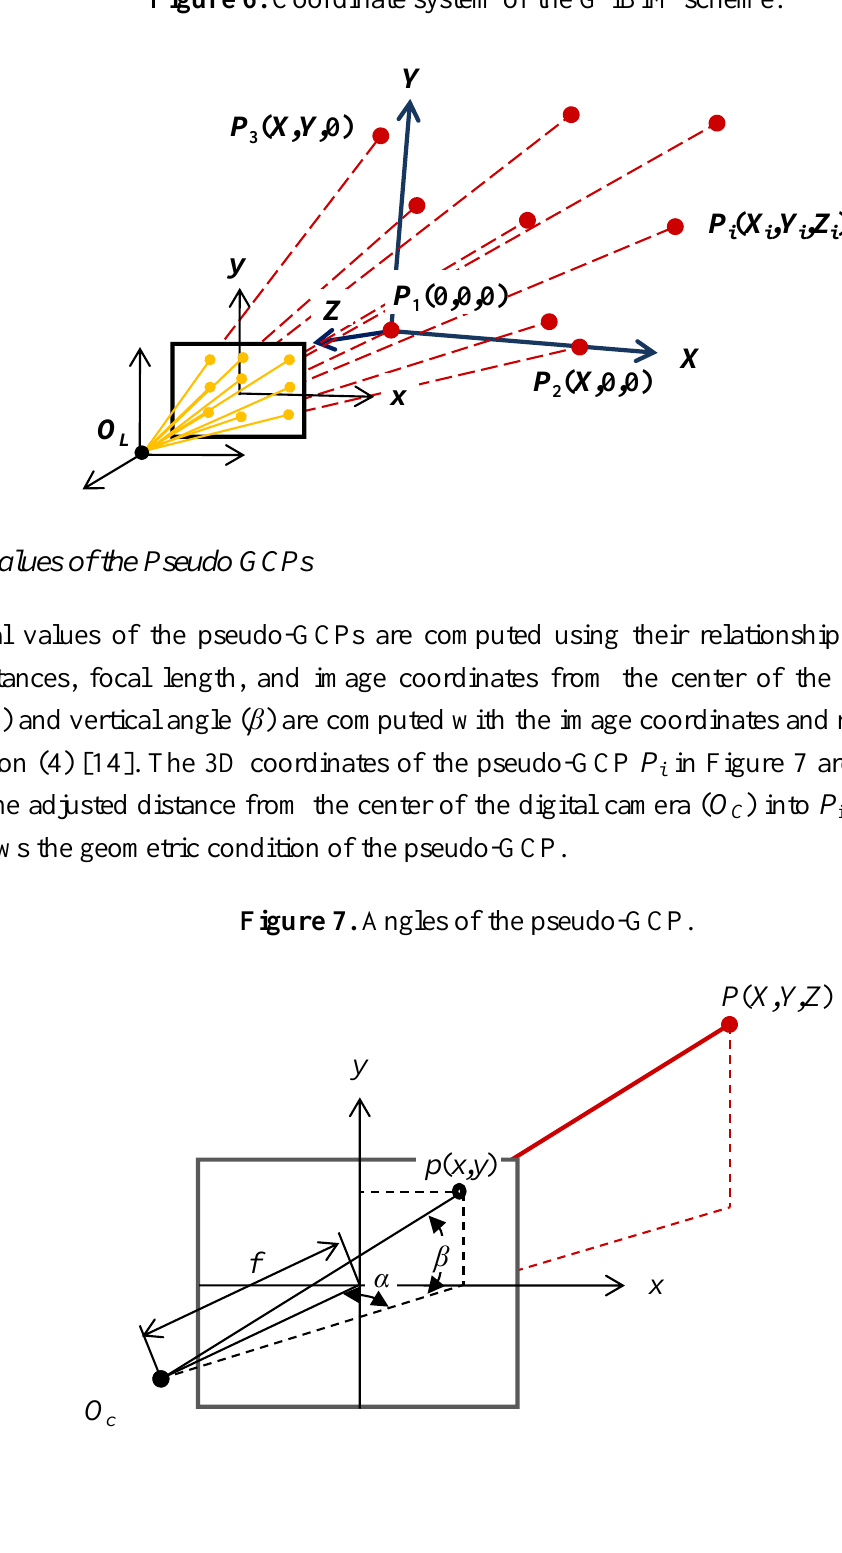
Figure 6. Coordinate system of the G-IBIM scheme.